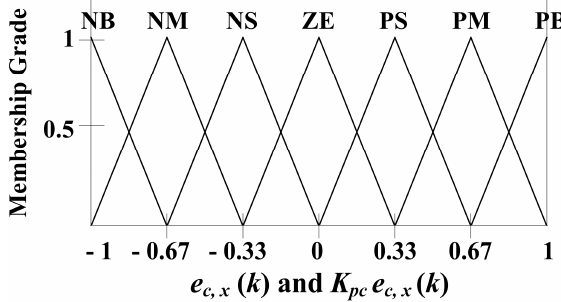
Figure 4. Normalized Membership Function set for (cid:1857) (cid:3030),(cid:3036)(cid:3051) (cid:4666)(cid:1863)(cid:4667) and (cid:1837) (cid:3043)(cid:3030) (cid:1857) (cid:3030),(cid:3036)(cid:3051) (cid:4666)(cid:1863)(cid:4667) .